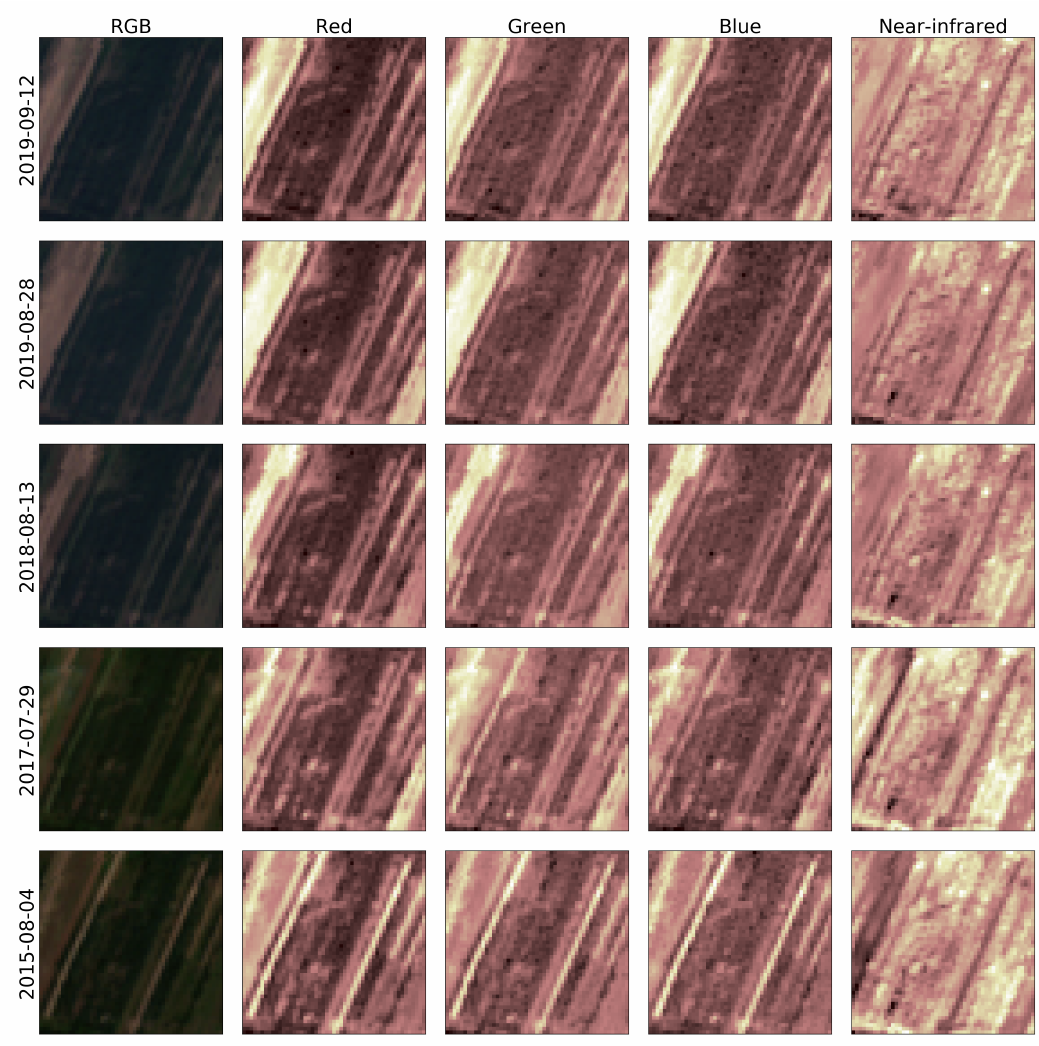
Figure 5. Time series of a single grid element classified as abandoned land. Original data class 4. The data sample is presented in RGB and near-infrared